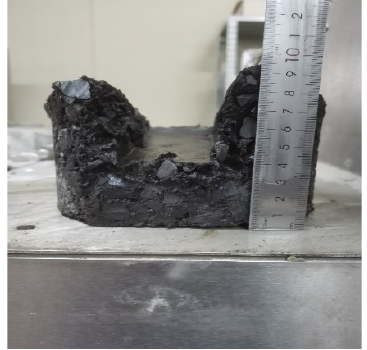
Figure 13. Specimen of HIPR-BF.